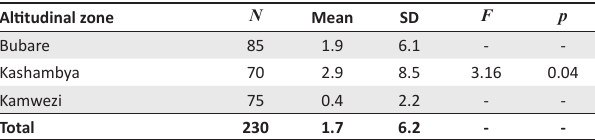
TABLE 4: Comparative sensitivity index by altitudinal zone. Altitudinal zone N